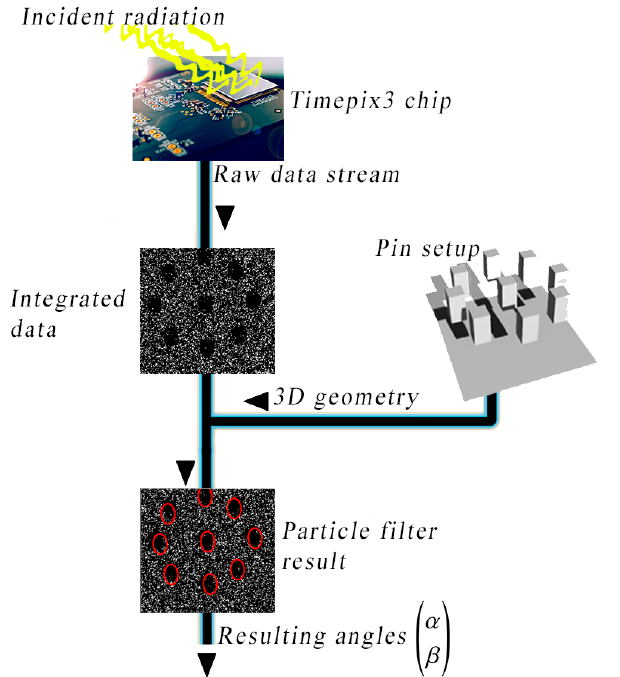
Figure 3. Snippet of the relevant parts of the schematic processing pipeline overview used to test the radiation angle detection algo-